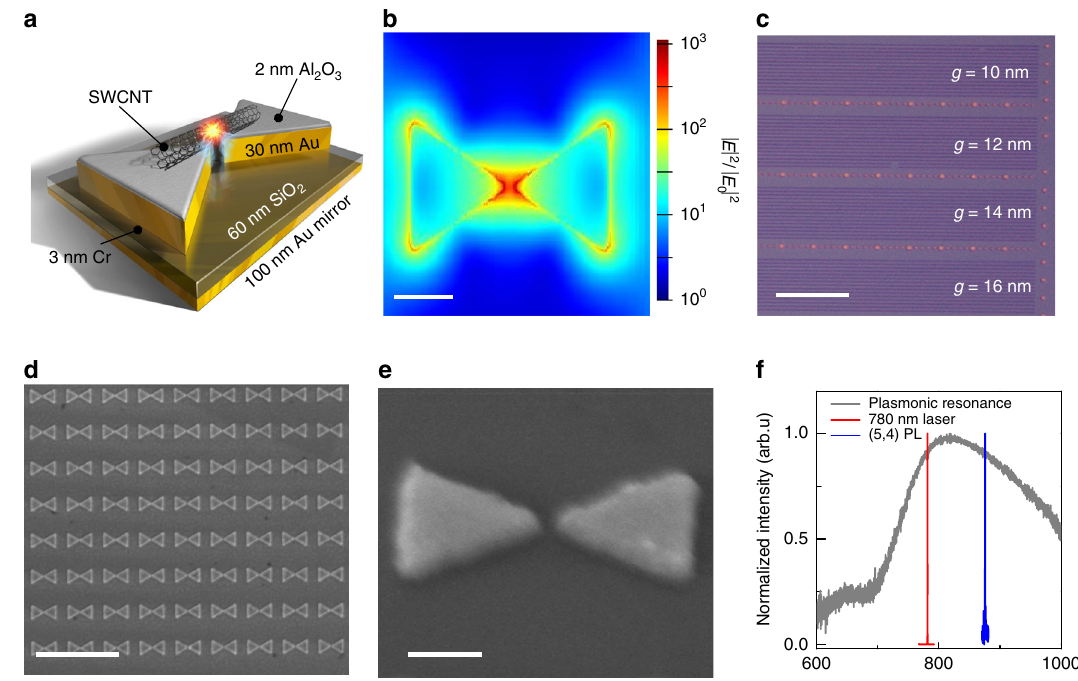
Fig. 1 Overview of plasmonically coupled carbon nanotube system. a Shematic of an individual single-wall carbon nanotube (SWCNT) suspended across a bowtie antenna. The SWCNT ( d < 1 nm) is portrayed with signi fi cantly larger scale than actual size for clarity. The SWCNT is separated from the plasmonic gold substrate by a 2 nm atomic layer deposition grown Al 2 O 3 spacer layer to prevent optical quenching and short circuit of the nanoplasmonic gap-mode underneath. b Finite-difference time-domain (FDTD) simulation of the corresponding fi eld enhancement distribution pro fi le including fi nite apex angles with 3 nm radius. Scale bar = 100 nm. c Bright- fi eld optical microscope image of the plasmonic array showing four 20 × 100 μ m 2 stripes each containing bowtie antennas with fi xed gap size g varying among stripes from 10 – 20 nm. The larger features are gold markers to enable repositioning to individual SWCNTs. Scale bar = 20 μ m. d The scanning electron microscope image shows high uniformity and orientation control of the plasmonic system. Scale bar = 2 μ m. e Zoom into an individual bowtie antenna with 10 nm gap showing sharp and straighth edges. Scale bar = 100 nm. f Plasmon resonance spectrum ( Q = 6) recorded in dark- fi eld transmision geometry (gray) together with 780 nm pump laser spectrum (red) and exciton emission spectrum of a (5, 4) SWCNT (blue) showing spectral resonance is full fi lled simultaneously for both SWCNT absorption and